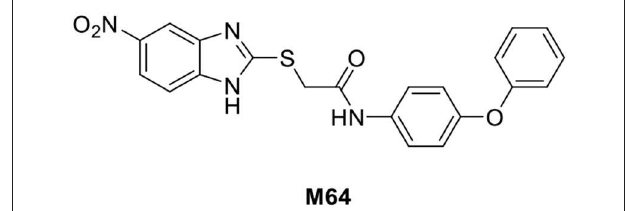
FIGURE 1 | Chemical structure of the M64 PqsR